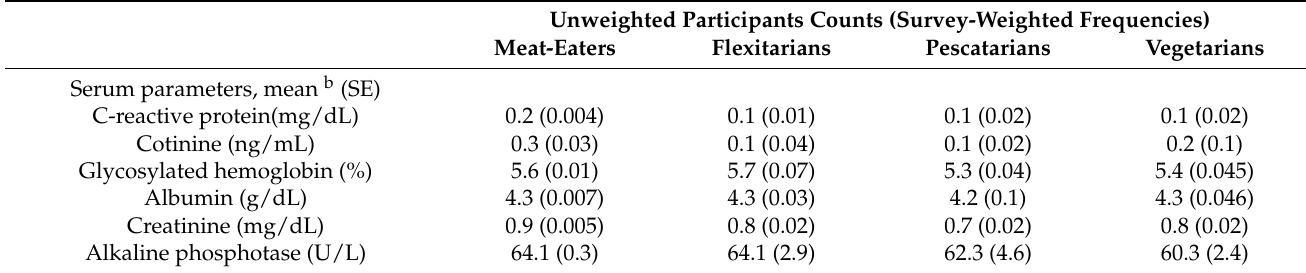
Table A2. Survey-weighted serum parameters of NHANES 2007–2010 study participants following a meat-eating, flexitarian, pescatarian or vegetarian diet (n = 8885 a ).